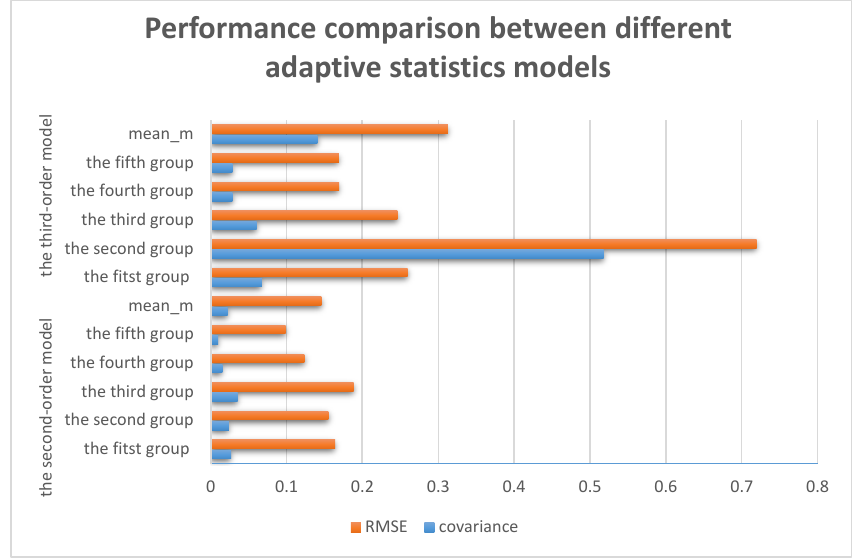
Figure 6. Covariance and RMSE of the adaptive statistics